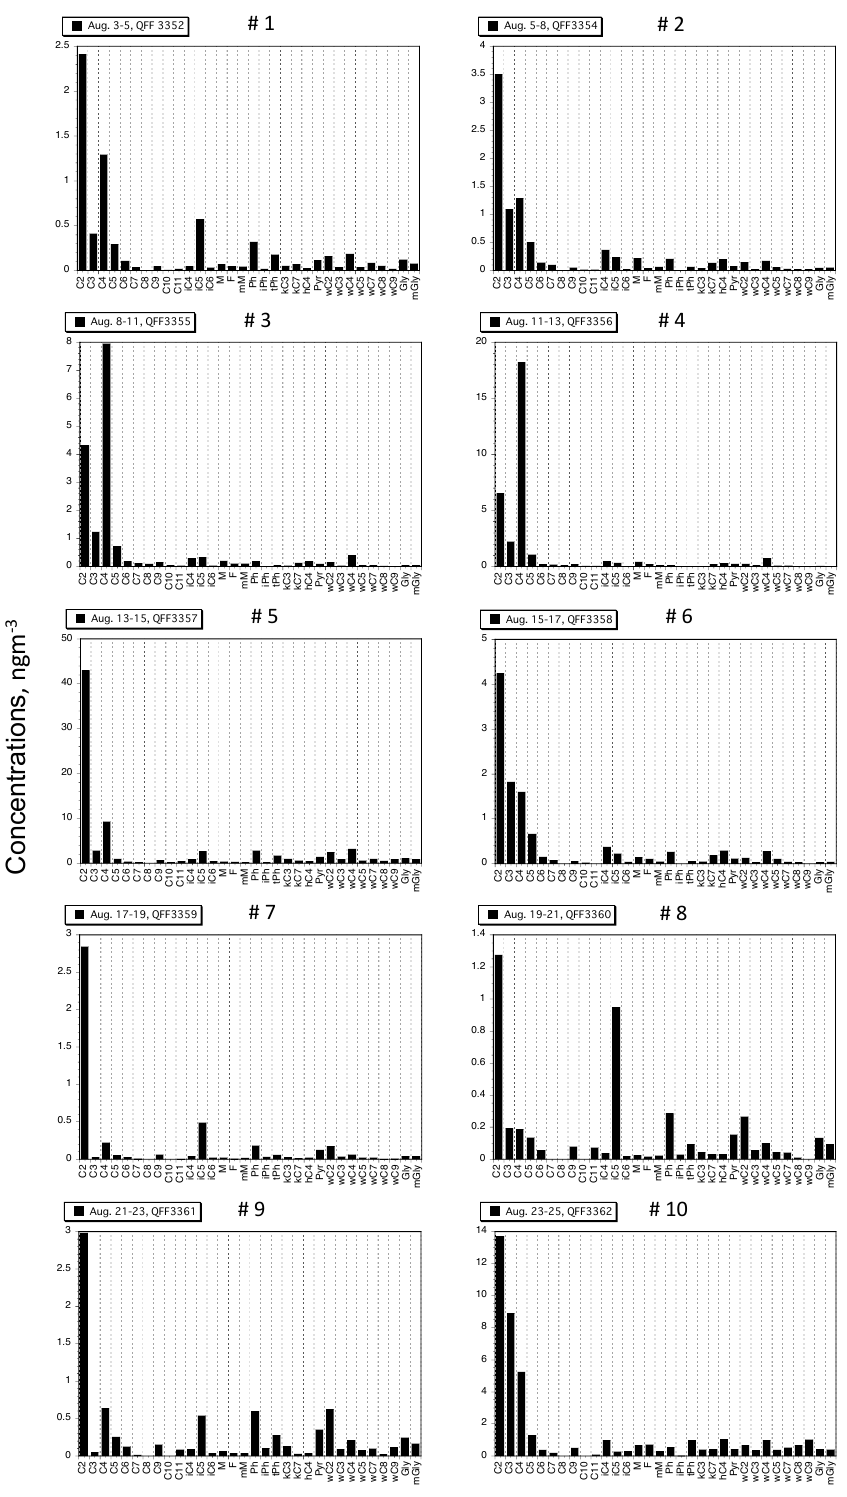
Fig. 4. Molecular compositions of low molecular weight dicarboxylic acids (C 2 -C 10 ), ketocarboxylic acids (C 2 -C 9 ) and α -dicarbonyls (glyoxal and methylglyoxal) in the Arctic marine aerosols. For the details of samples #1–#10, see Fig. 1. For the abbreviations of compounds, see Table